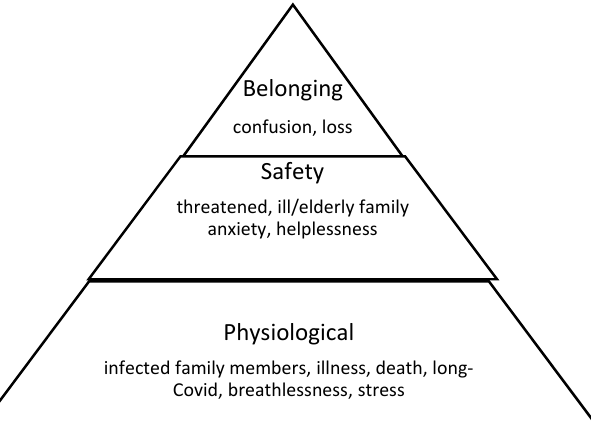
Figure 2. Maslow’s Basic Human Needs: COVID Impacts on VFR Travellers .